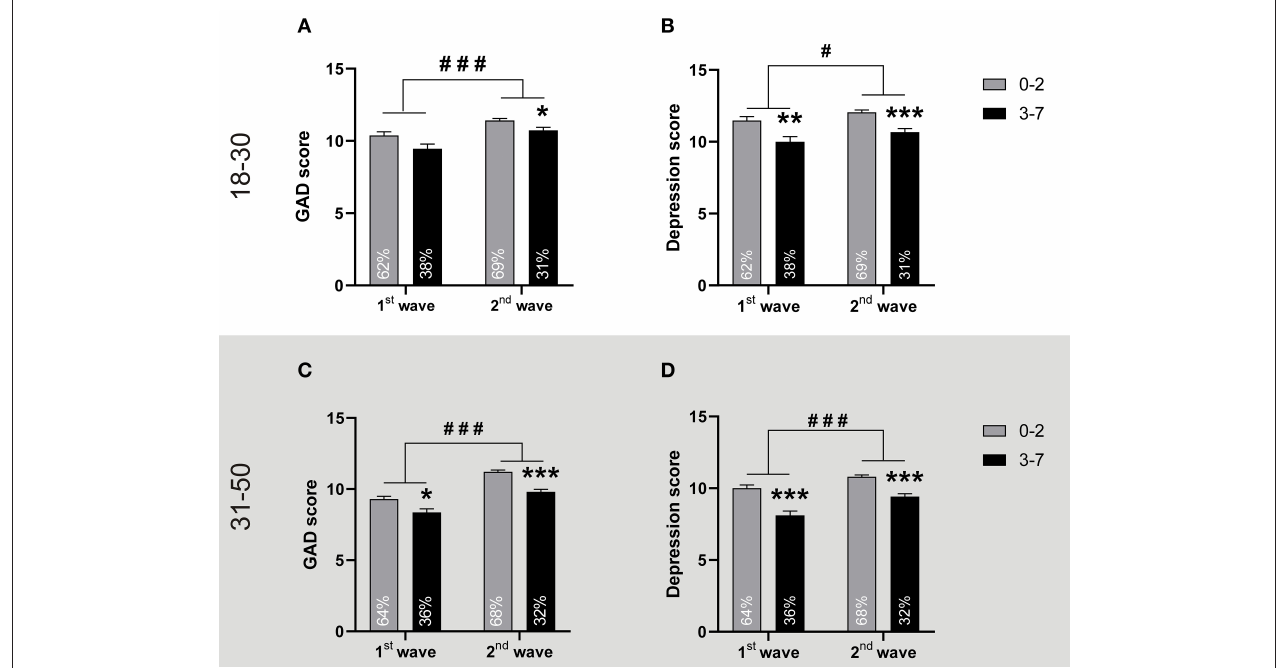
FIGURE 5 | Practicing physical activity more than 2 days per week is associated with lower GAD and depression. Top panel: People aged between 18 and 30. The figures show the mean + SEM of (A) GAD scores and (B) Depression scores of young adults who practiced physical up to 2 days per week (0–2), or more (3–7), in the 1st wave and in the 2nd wave ( n = 428; 257; 1,266 and 578, respectively). * p < 0.05, ** p < 0.01, and *** p < 0.001 vs. 0–2 group and # p < 0.05, ### p < 0.001 vs. 1st wave, after two-way ANOVA. Each bar also informs the percentage of the population studied in the wave that exercised with low or high frequency. For GAD scores: Cohen’s f 2 = 0.12 vs. 0–2 group in the 2 nd wave, η 2 p = 0.004 for the physical activity frequency factor and η 2 p = 0.009 for the wave factor. For depression scores Cohen’s f 2 = 0.15 and 0.23 vs. 0–2 group for the 1st and 2nd wave respectively; η 2 p = 0.010 for the physical activity frequency factor and η 2 p = 0.002 for the wave factor. The descriptive statistics are reported in Supplementary Table 5 . Bottom panel: People aged between 31 and 50. The figures show the mean + SEM of (C) GAD scores and (D) Depression scores of adults who practiced physical activity up to 2 days per week (0–2), or more (3–7), in the 1st wave and in the 2nd wave ( n = 542; 304; 1,870; and 862, respectively). * p < 0.05, *** p < 0.001 vs. 0–2 group and ### p < 0.001 vs. 1st wave, after two-way ANOVA. Each bar also informs the percentage of the population studied in the wave that exercised with low or high frequency. For GAD scores: Cohen’s f 2 = 0.09 and 0.26 vs. 0–2 group in the 1st and 2nd wave respectively, η 2 p = 0.008 for the frequency of physical activity factor and η 2 p = 0.017 for the wave factor. For depression scores Cohen’s f 2 = 0.19 and 0.24 in the 1st and 2nd wave respectively; η 2 p = 0.0134 for the frequency of physical activity factor and η 2 p = 0.0056 for the wave factor. The descriptive statistics are reported in Supplementary Table 5